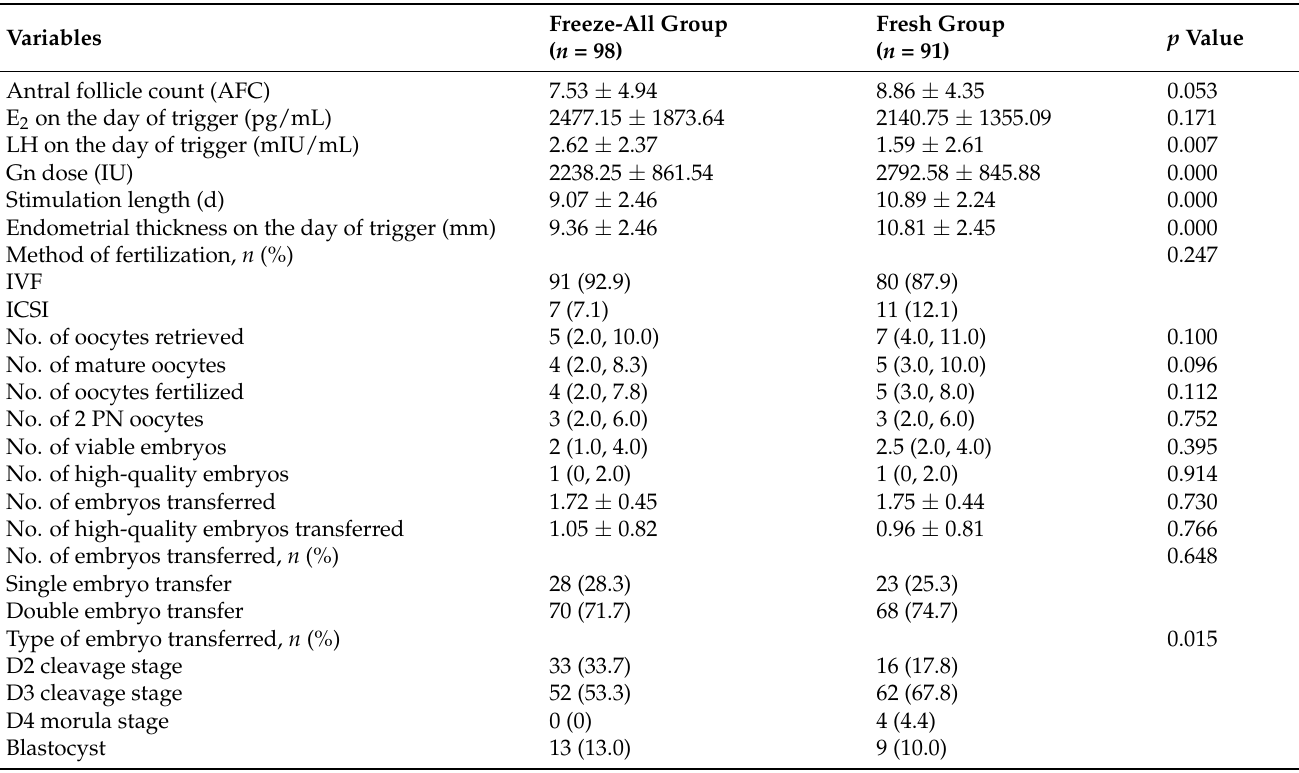
Table 2. Ovarian stimulation, embryology and transfer data between freeze-all and fresh